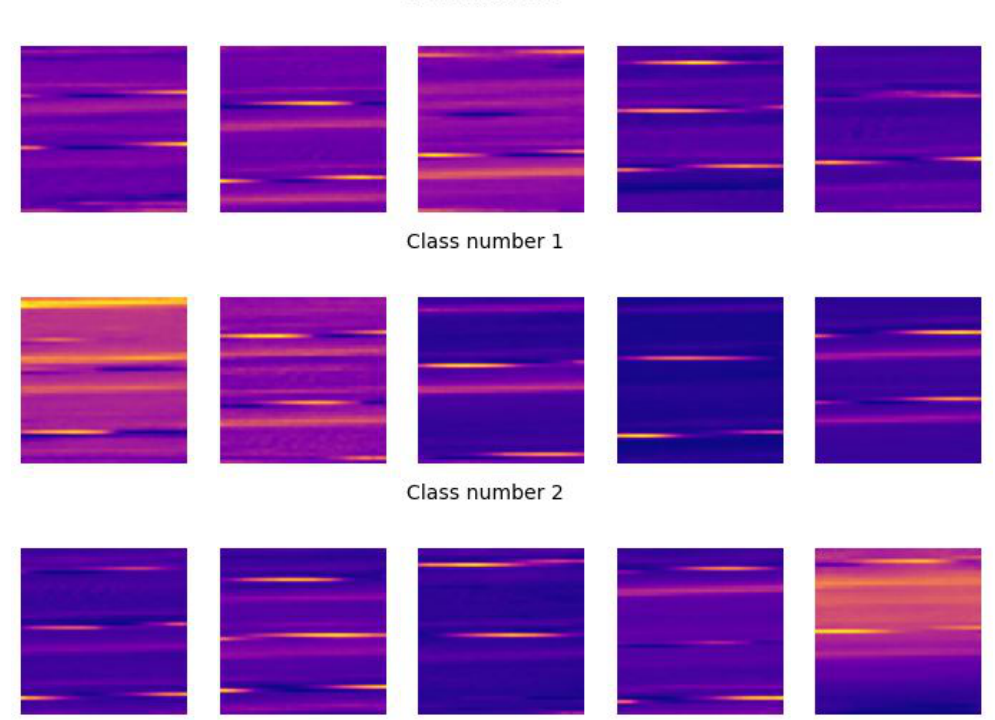
Figure 20. Generated images for the ACGAN model after 400 epochs training.